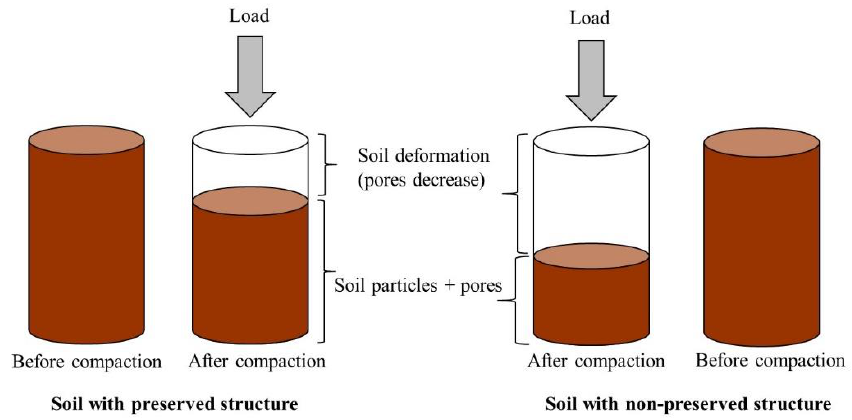
Figure 5. Soil with preserved and non-preserved structure with the same bulk density before the uniaxial compression test and the differences in soil deformation and pores decrease at the end of the test.